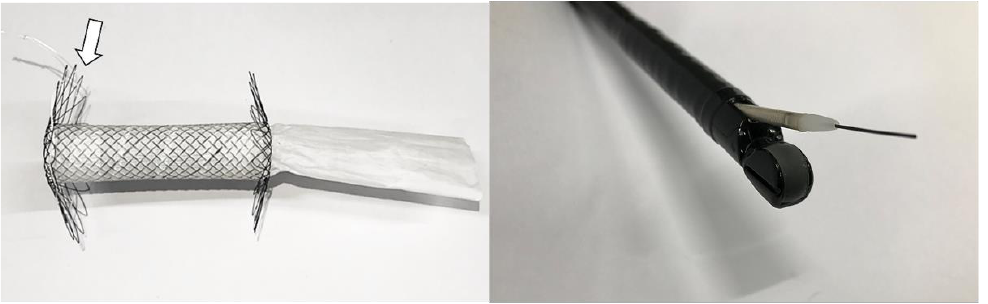
Figure 2. Photograph of G-DFR with proximal lasso (arrow) and 60 mm PTFE skirt. An over the wire of the stent introducer with 10.5 Fr outer diameter in an echoendoscope with 3.8 mm diameter of working channel. G-DFR, Gastro-duodenal flow restrictor; PTFE, polytetrafluoroethylene.